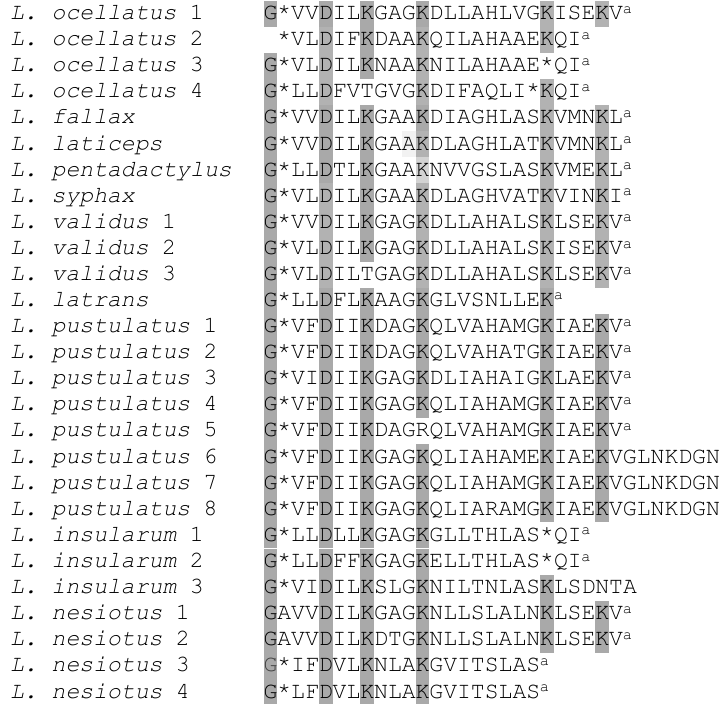
Figure 4. Sequence alignment of the ocellatin peptides from L. insularum and L. nesiotus with the orthologous peptides from other Leptodactylus species isolated to-date. Gaps denoted by (*) are introduced into certain sequences in order to maximize the structural similarity of the peptides. Shading is used to indicate the amino acid residues that have been very strongly conserved. a denotes C-terminal α -amidation.